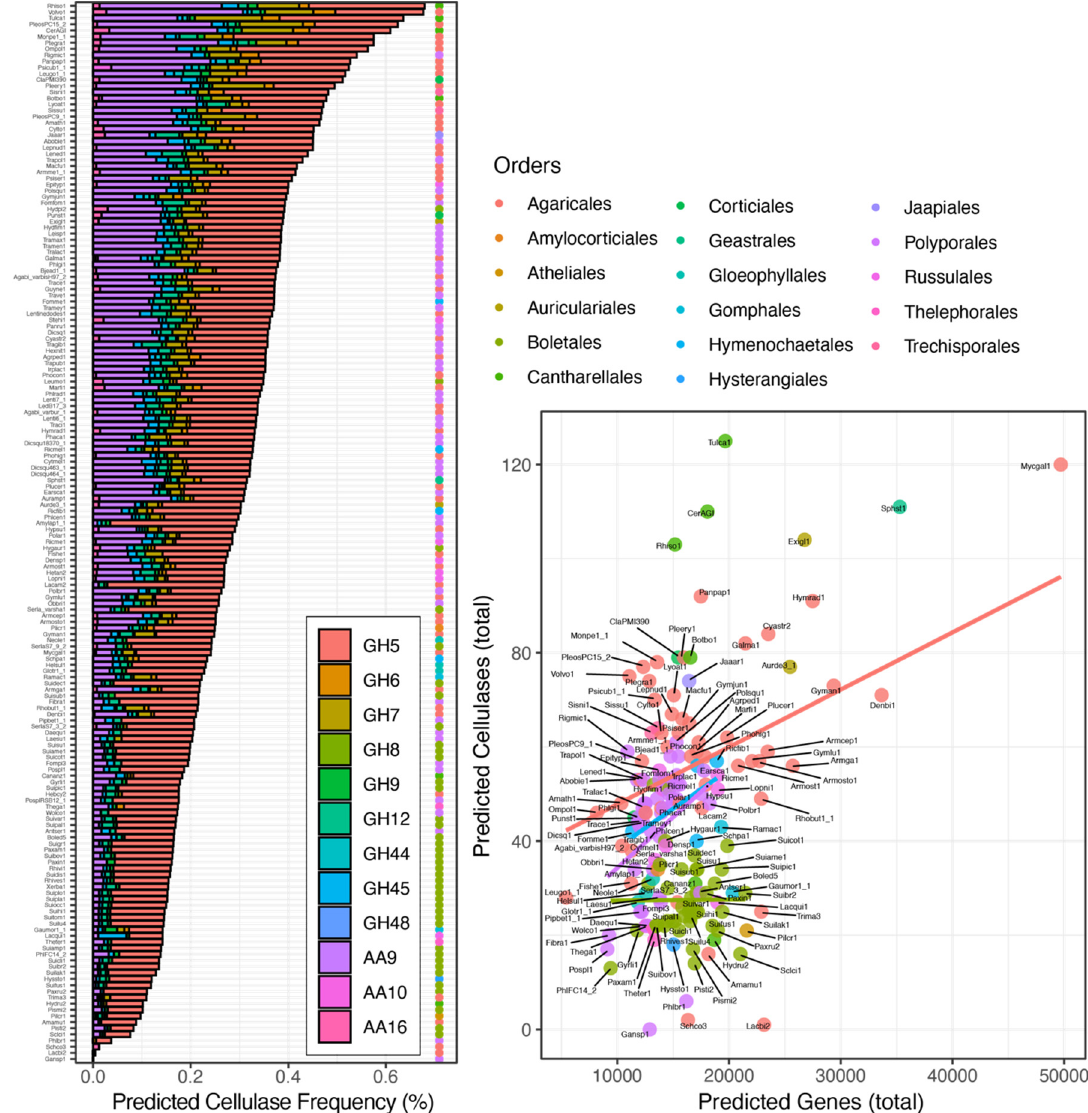
Figure 2. The functional potential for cellulose deconstruction in sequenced genomes from the class Agaricomycetes ( n = 172 genomes). Frequency of the predicted potential cellulases (left) and total number of predicted potential cellulases across orders of Agaricomycetes (right). Lines depict the linear regression between the predicted cellulases and the predicted number of genes, if correlated (i.e., P Pearson < 0.05).